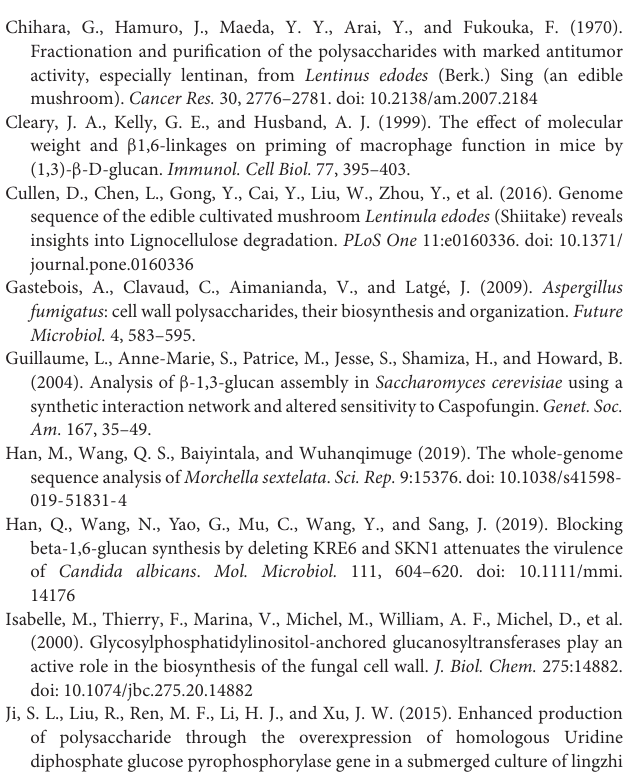
Supplementary Table 10 . MAPK signaling pathway-yeast was shown in Supplementary Figure 1 . Longevity regulating pathway-yeast was shown in Supplementary Figure 2